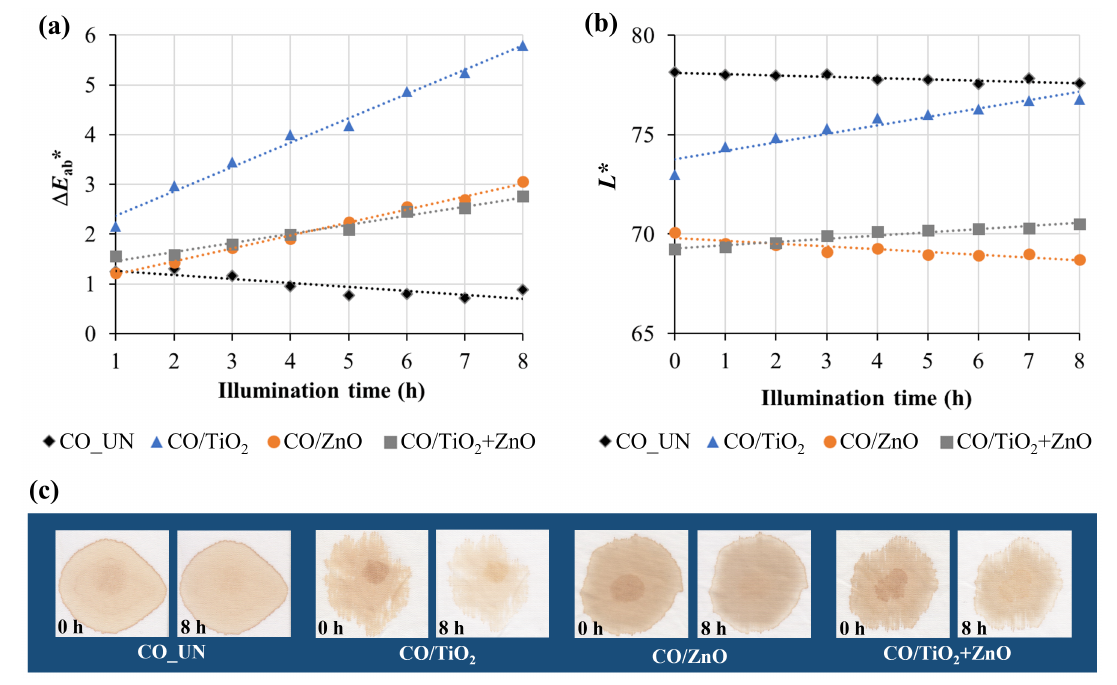
Figure 9. Colour difference, ∆ E ab *, between the unilluminated samples stained by coffee and the stained samples illuminated by the simulated solar light for different periods of time ( a ); the lightness, L ab *, of the stained samples before and after visible light illumination for different periods of time ( b ); digital images of the samples stained by coffee before and after 8 h of visible light illumination ( c